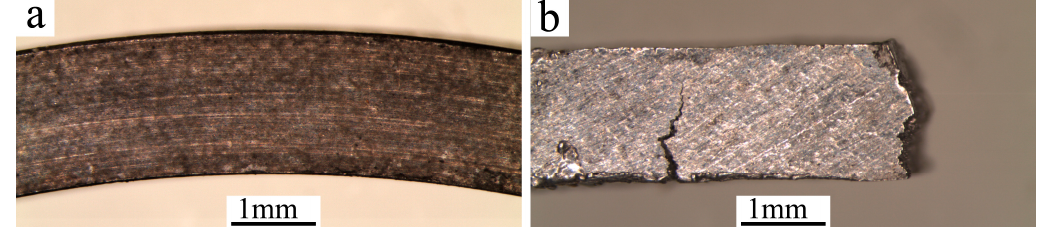
Figure 1. Macroscopic observation of ( a ) a ring at the initial state; and ( b ) a fragmented piece from a ring that was air-cooled after the expansion